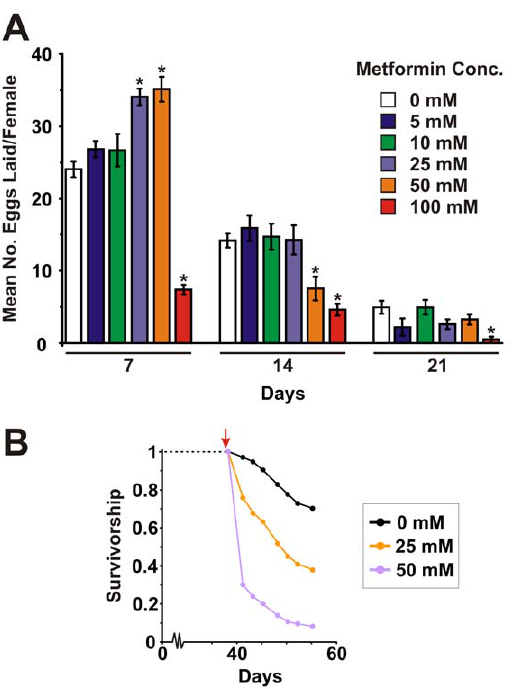
Figure 3. Effects of metformin on female egg-laying and post- reproductive survival. ( A ) Egg-laying profiles of wild-type females treated with 0 mM, 5 mM, 10 mM, 25 mM, 50 mM and 100 mM metformin. Eggs were counted from 10 vials per treatment (10 females per vial) over a 24 hour period after 7, 14 and 21 days of metformin treatment. Data are shown as means 6 SEM. * denotes statistically significant difference ( P , 0.05). No significant differences were observed in egg-laying between females on 0 mM, 5 mM and 10 mM